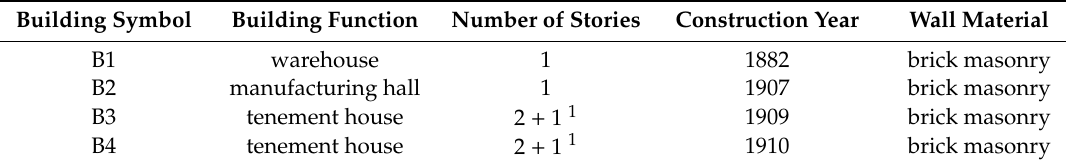
Figure 1. The facade-side view of the buildings: ( a ) warehouse building-B1; ( b ) manufacturing hall-B2; ( c ) tenement house-B3; ( d ) tenement house-B4. Table 1. Characteristics of buildings.